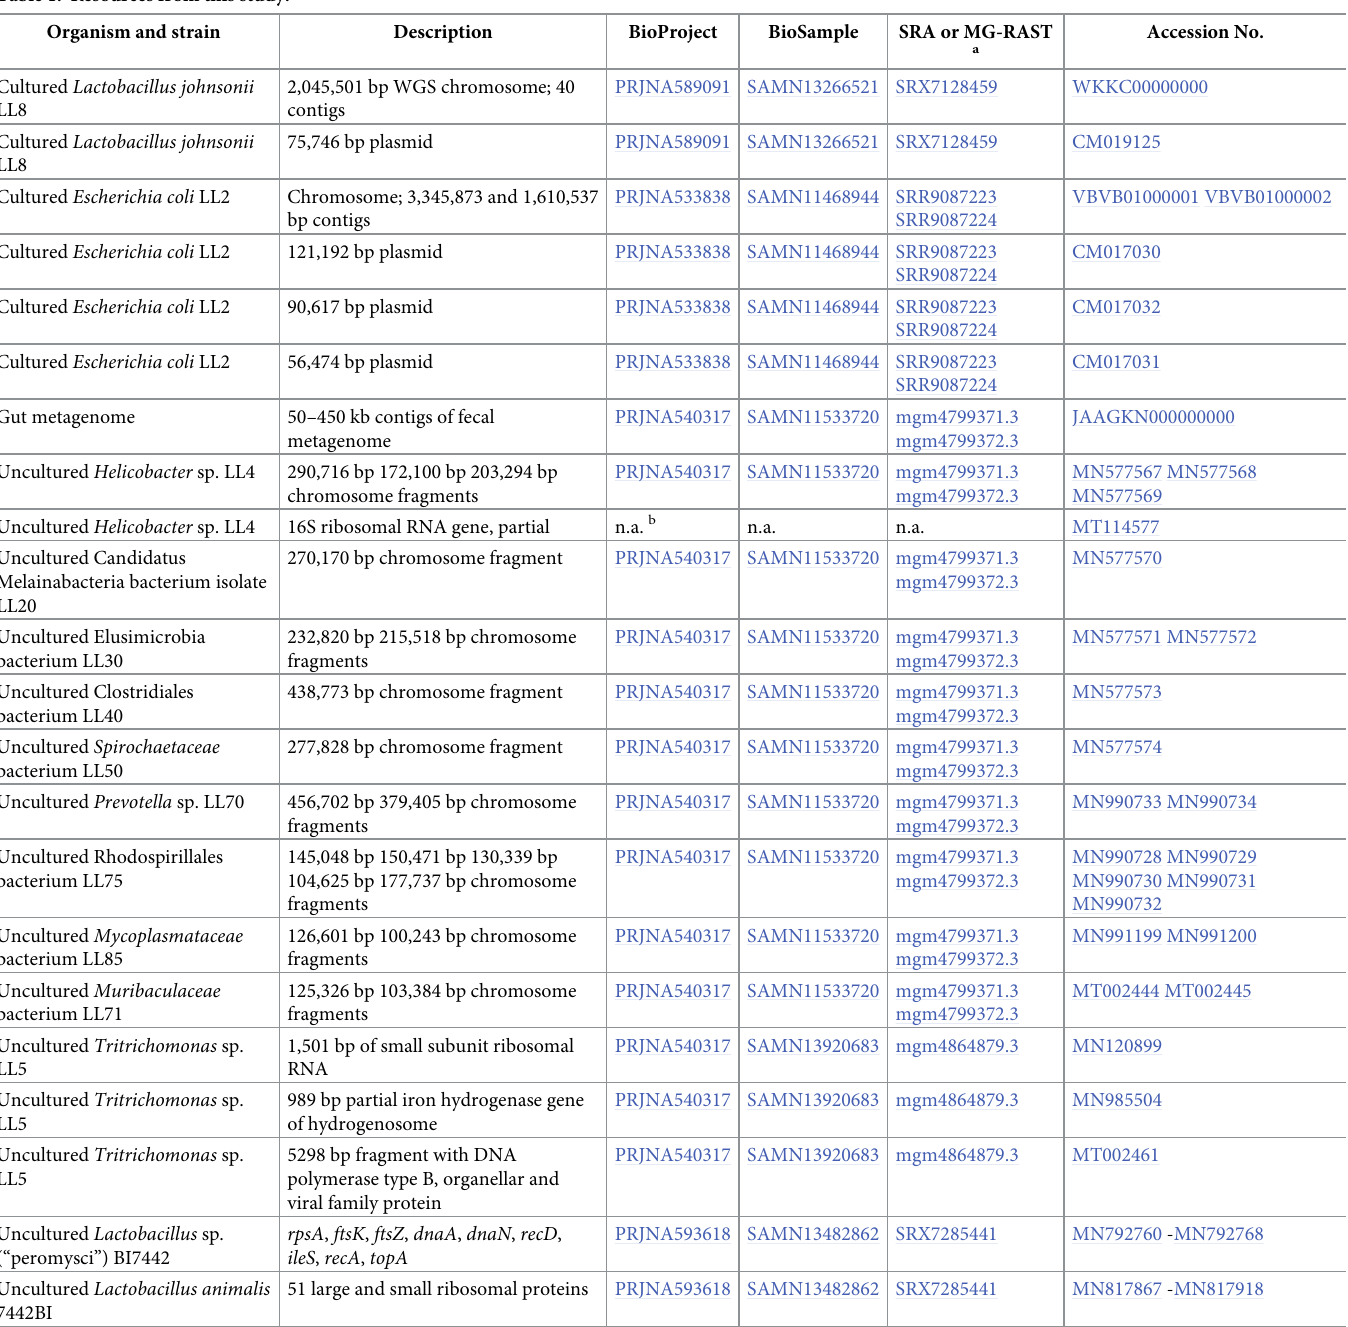
Table 1. Resources from this